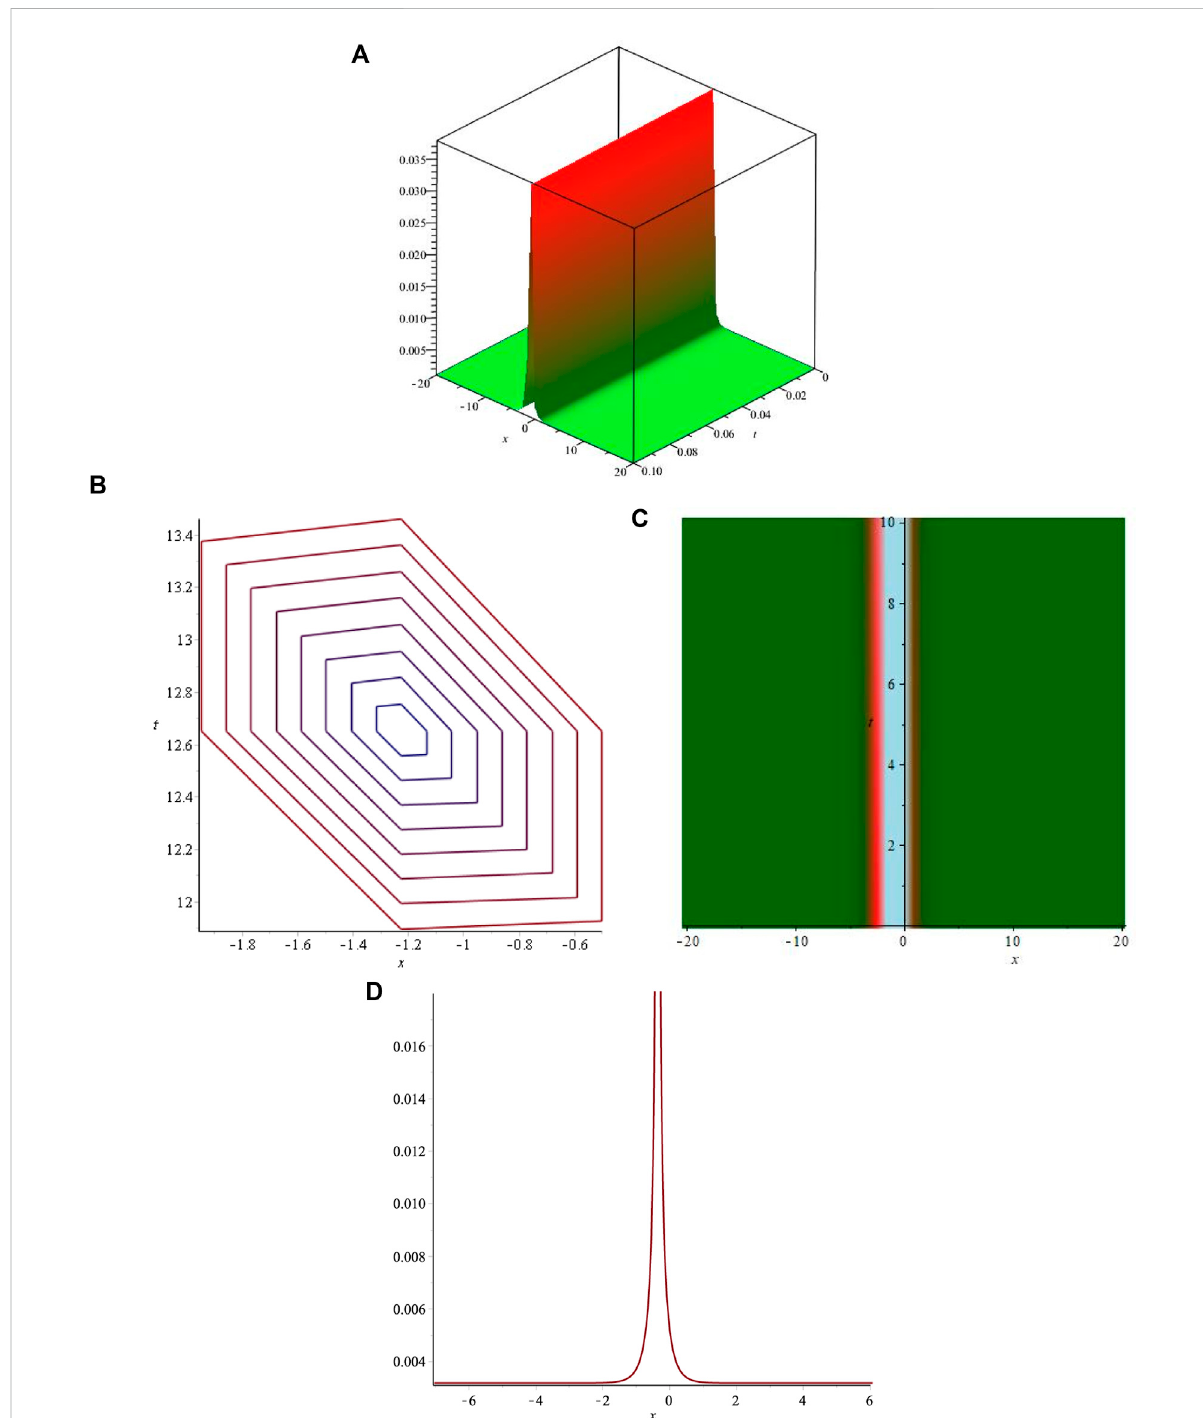
Graphical representations of (cid:7) Λ 8 2 ( x , t )(cid:7) 2 for c 1 = ϵ = D = a = b = ϑ 1 = κ =0.11, and the remaining arbitrary constants are assigned the value of